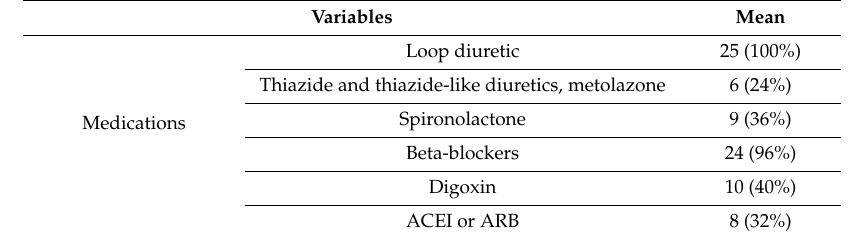
Table 1. Cont. Variables Mean